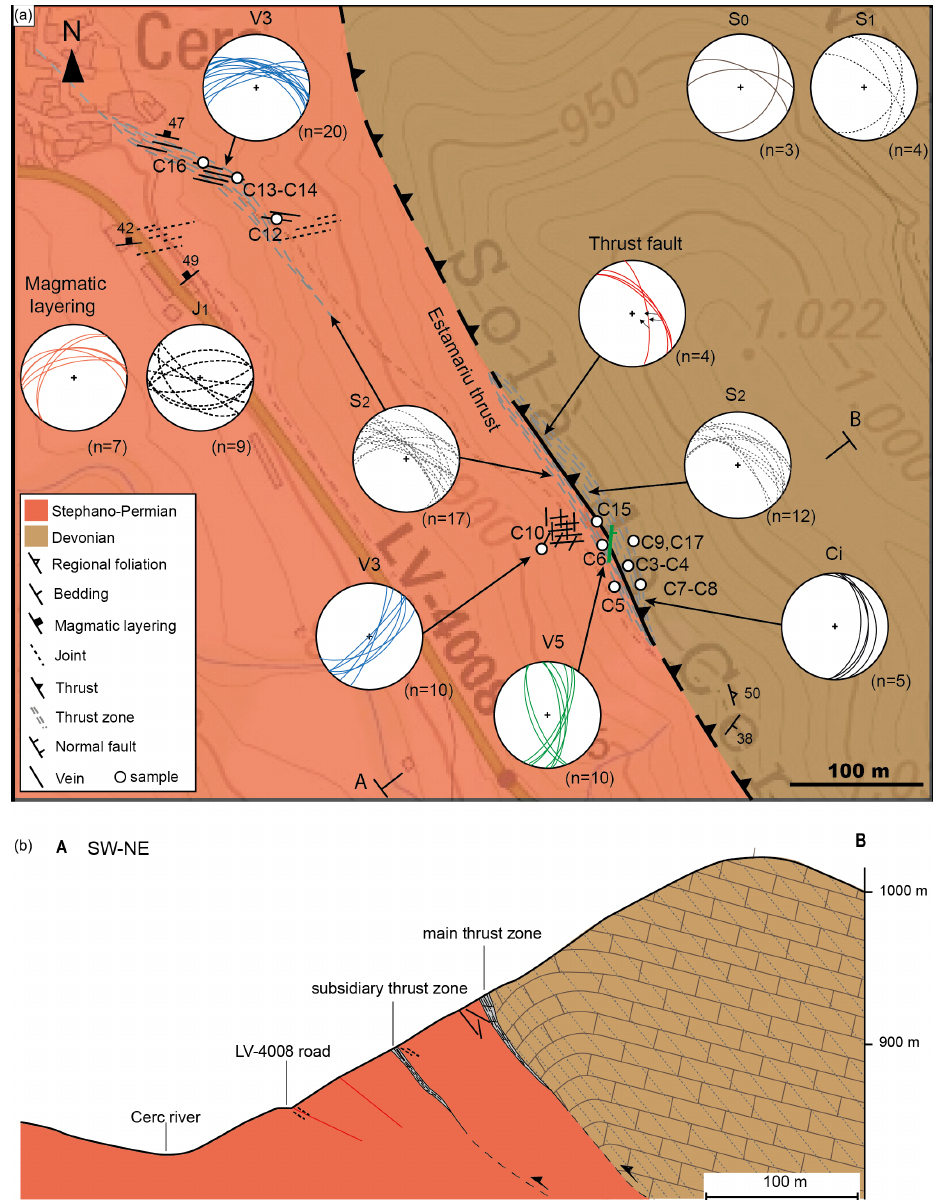
Figure 2. (a) Geological map and (b) cross section of the Estamariu thrust, which juxtaposes a Devonian unit against a Stephano-Permian sequence ( H = V , no vertical exaggeration). Lower-hemisphere equal-area stereoplots of the Devonian bedding (S 0 ), regional foliation (S 1 ), and thrust zone foliation affecting the hanging wall and footwall (S 2 ); magmatic layering and the different faults and veins observed in the study area are also included. Location in Fig.